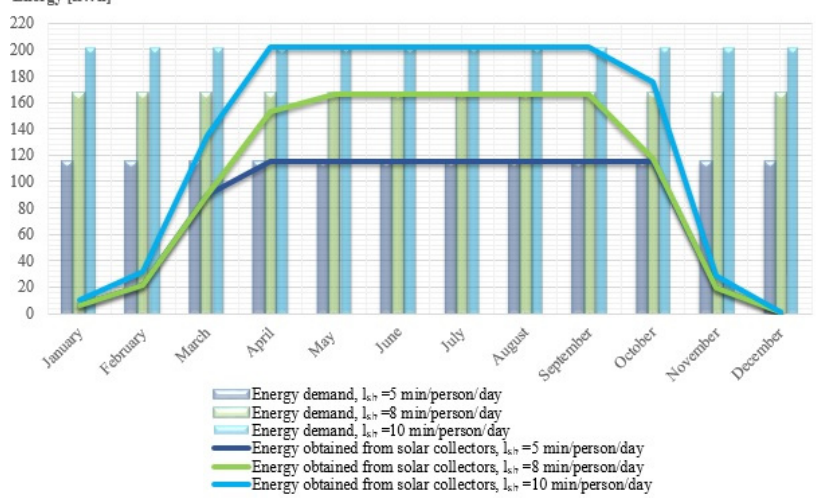
Figure 11. Energy demand for hot water heating and energy obtained from solar collectors.